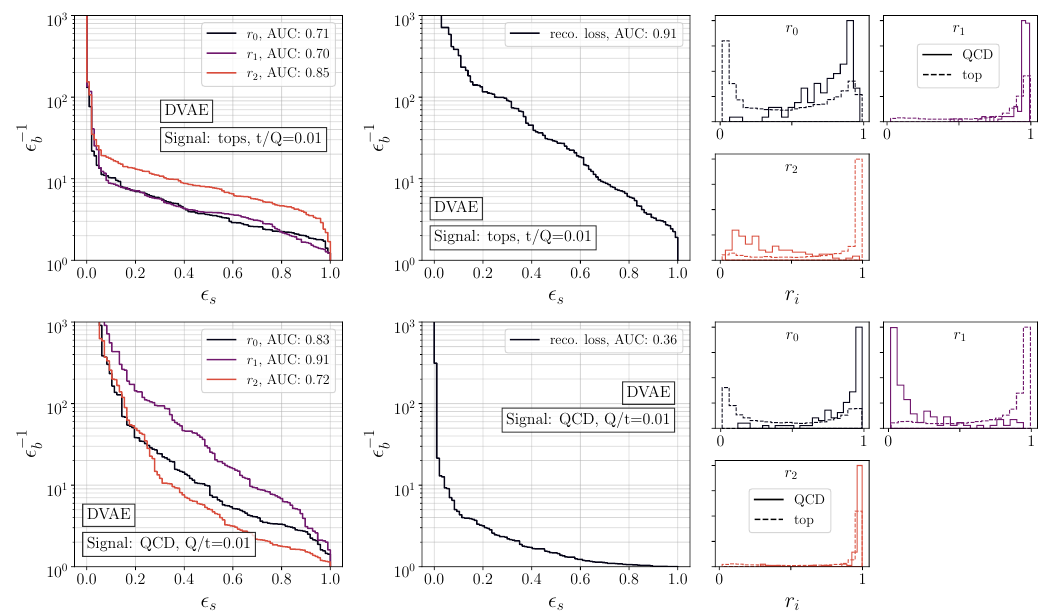
Figure 11: DVAE results using 3 mixture components ( R = 3) for various amounts of anomalous top (upper) and QCD (lower) jets in the sample, where the mixture weights (left) and the reconstruction loss (middle) are used for classification. In the small panels we show the distributions of QCD and tops along each direction in latent space.